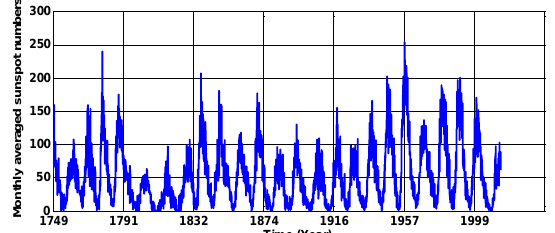
Figure 1: Sunspot cycle evolution-Monthly averaged sunspot numbers from the year 1749 to December